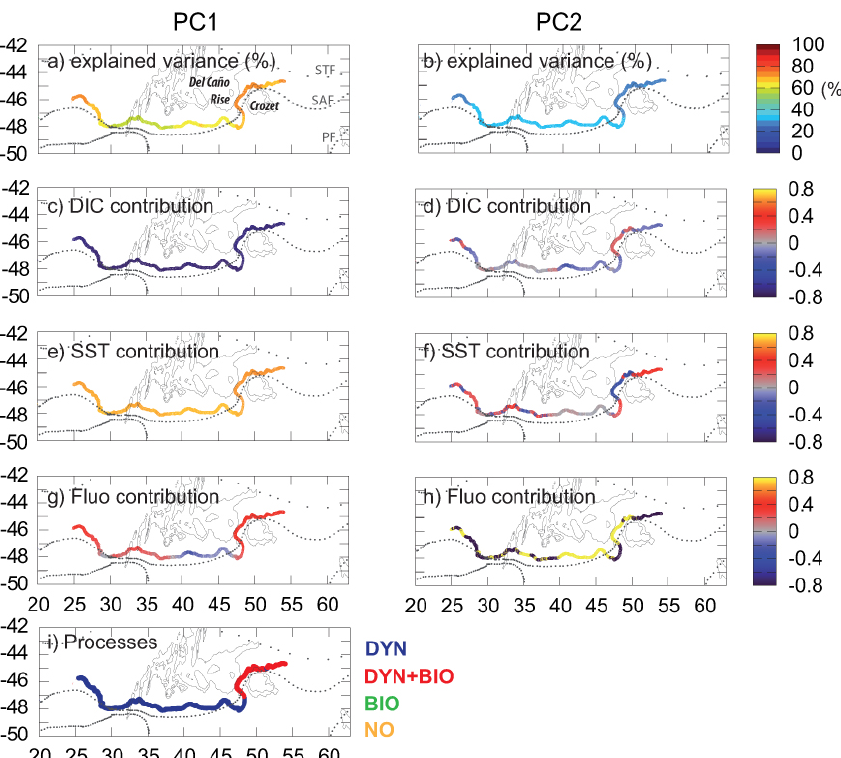
Fig. 4. Principal component analysis in the case study area: explained variance by (a) PC1 and (b) PC2; DIC loadings for (c) PC1 and (d) PC2; SST loadings for (e) PC1 and (f) PC2; fluorescence loadings for (g) PC1 and (h) PC2 and (i) dominant processes influencing DIC identified using PC1 loadings: ocean dynamics (DYN), biological uptake of DIC (BIO) and others (NO).